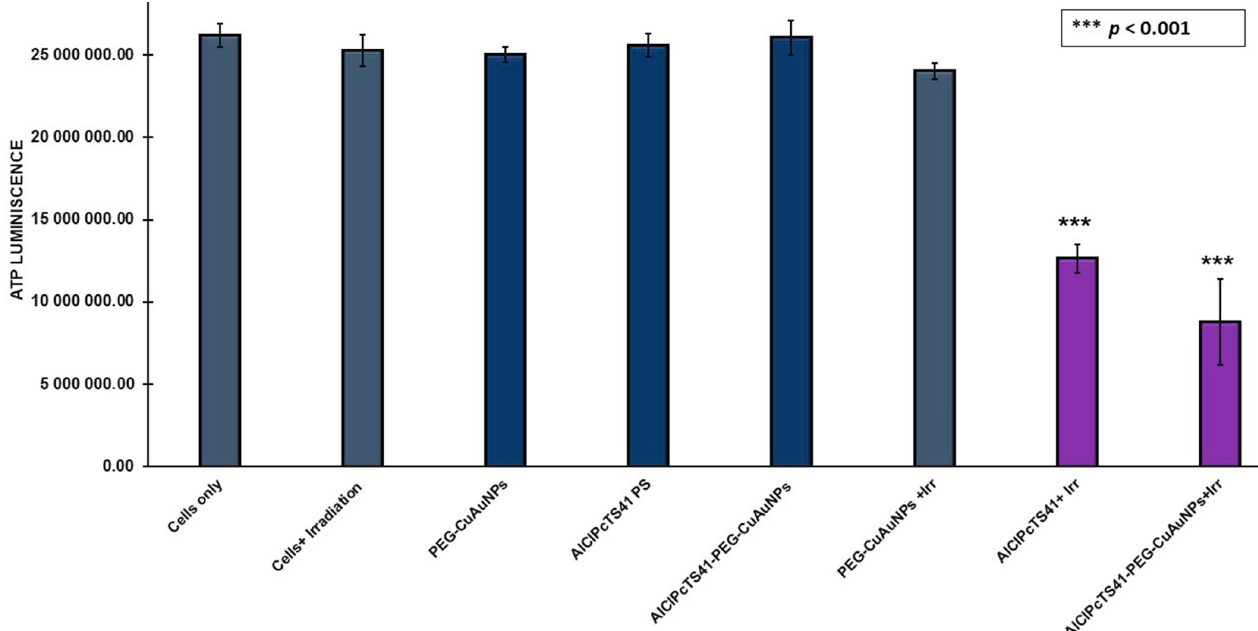
Figure 13. Effect of AlClPcTS41, PEG-CuAuNPs and AlClPcTS41-PEG-CuAuNPs combined with or without light irradiation at 636 nm at a of fluency 10 J/cm 2 on cell proliferation ( p < 0.001 ***) on cell proliferation. Significant decrease in cell proliferation rate, p < 0.001 *** in Caco-2 cells incubated with IC 50 ′ s with respect to the control group.